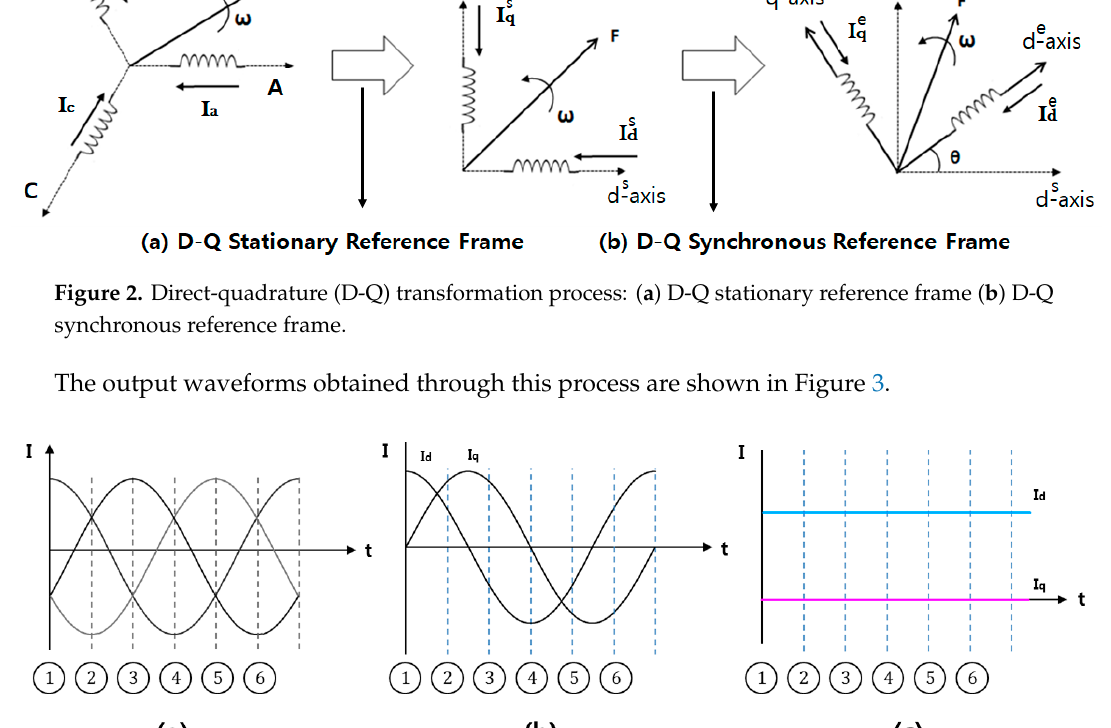
Figure 3. Current change due to D-Q transformation ( a ) 3-phase input current, ( b ) D-Q stationary coordinate system, ( c ) D-Q synchronous coordinate system.